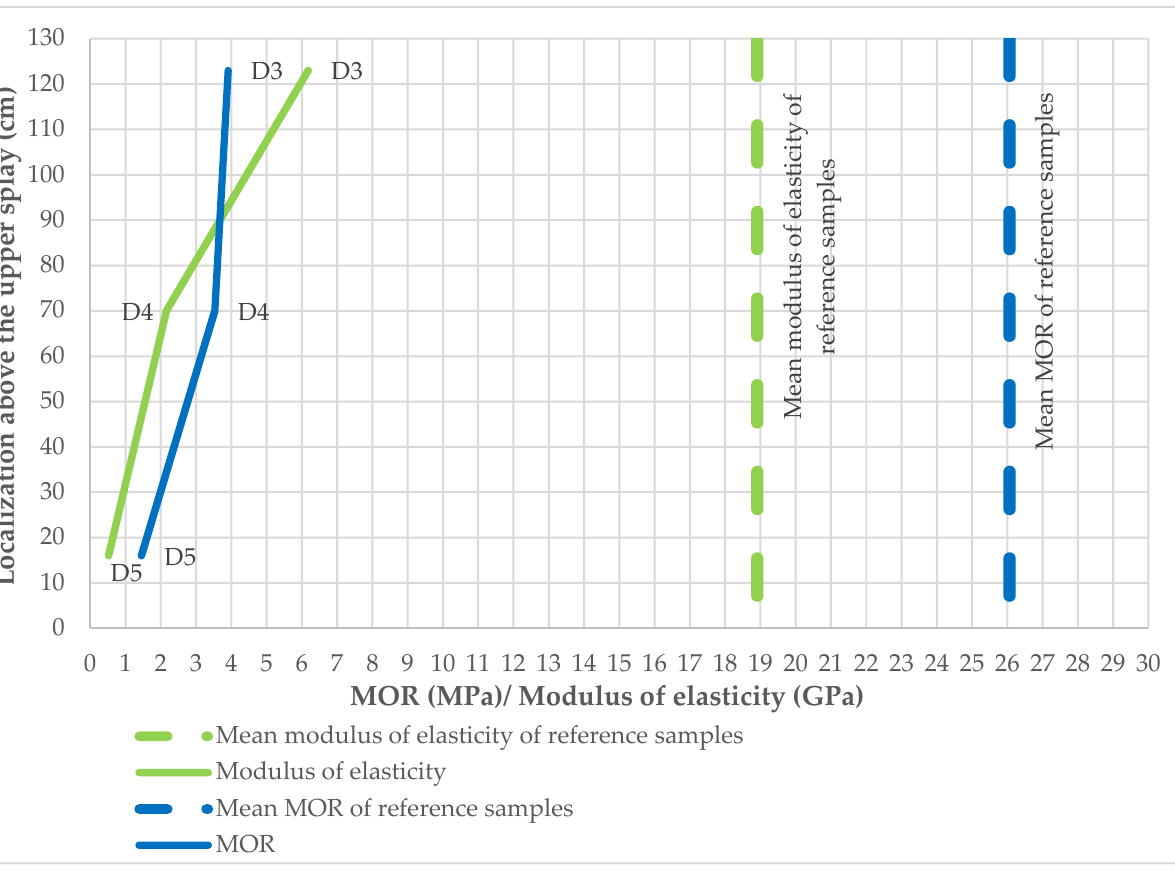
Table 2. Characteristic data of falling samples.